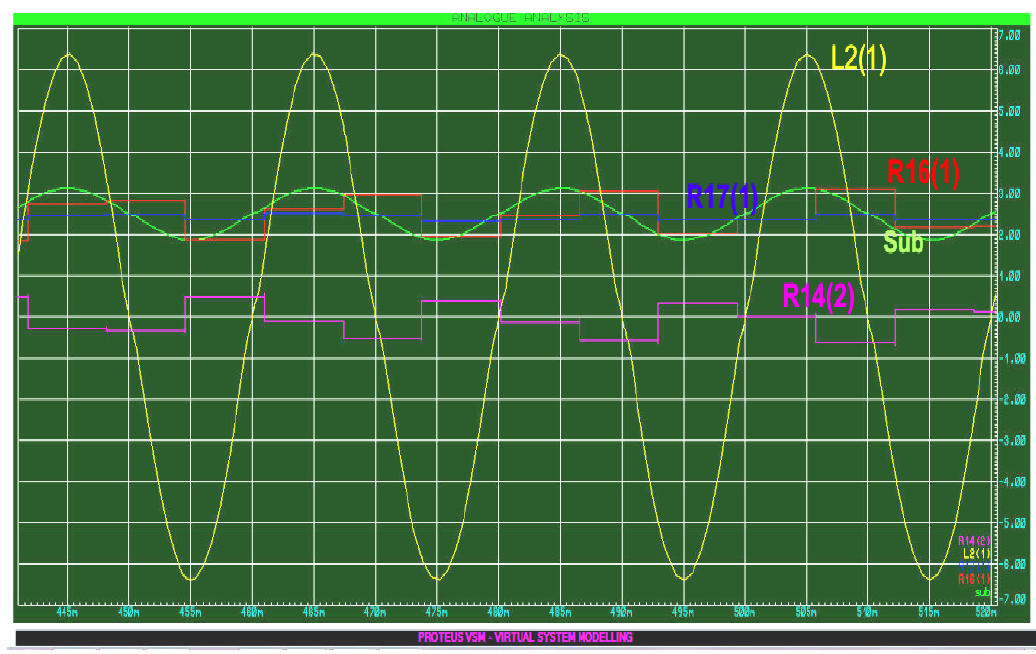
Figure 16. Simulation results of SAPF based on Proteus VMS, (R16 (1): Io; R14 (2): Iref; L2 (1): source voltage).